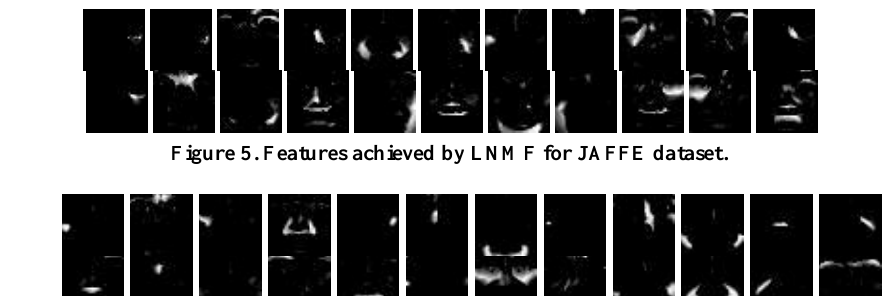
Figure 6. Features achieved by LNMF for MUG dataset.